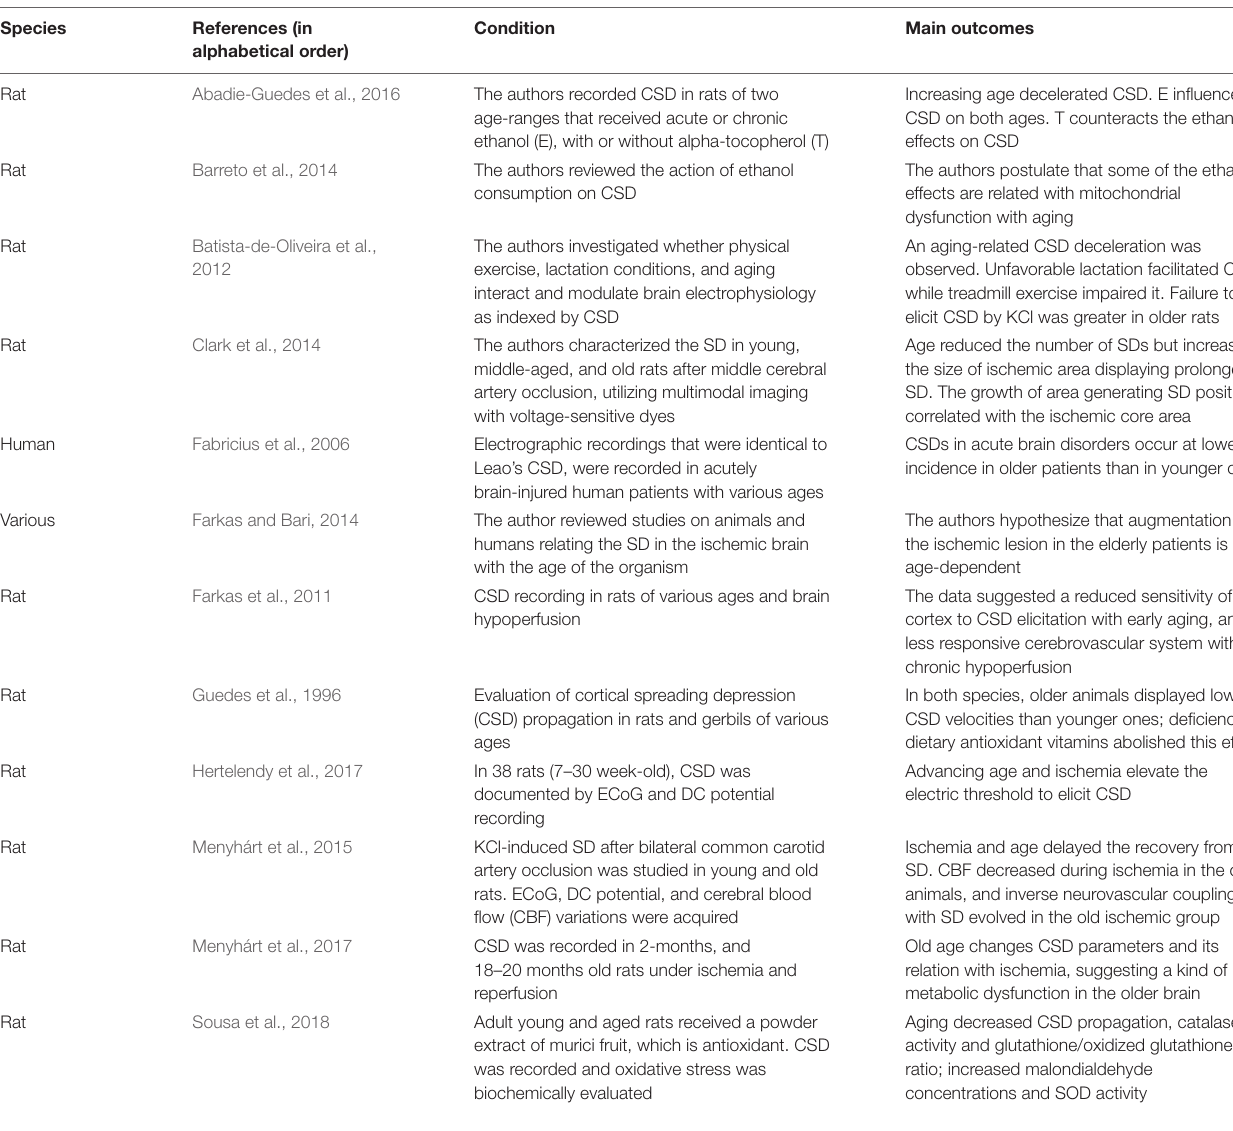
TABLE 1 | Some studies involving aging and